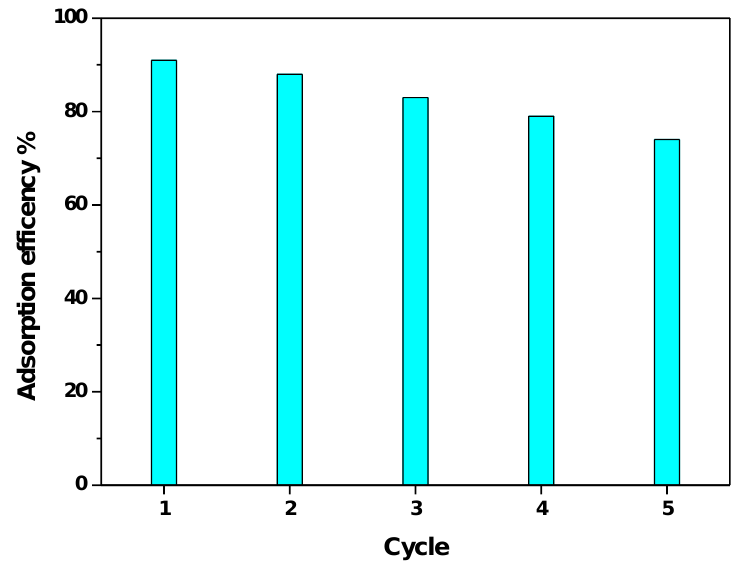
Figure 7. Adsorption efficiency of MB in five adsorption – desorption cycles for CNF2. From the results, it is possible to conclude that TOCNF2 is a promising material for MB absorption due to its higher adsorption capacities in comparison with those of other adsorbents based on polysaccharide-modified cellulose nanofibers (Table 3). Table 3. Maximum adsorption capacity of methylene blue by modified polysaccharides.